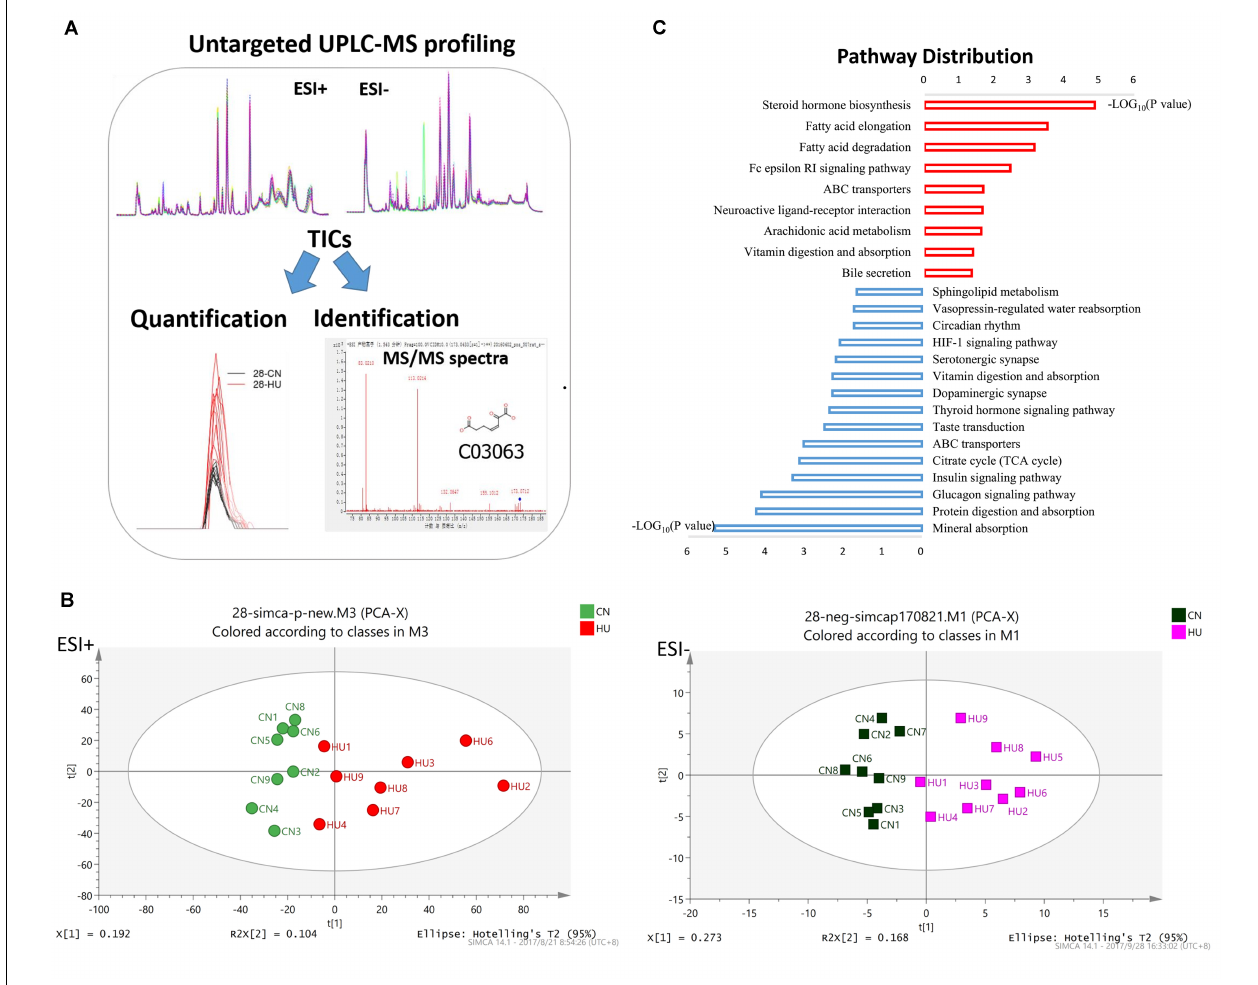
FIGURE 1 | Serum metabolomics reveals different metabolic profiles between control and HU rats. (A) Metabolomic workflow. (B) PCA plot of scores separating HU-28 (red in ESI+ and pink in ESI–) and control (green in ESI+ and black in ESI–) serum samples. (C) Abundance of discriminating metabolites in pathways according to KEGG analysis. The red column or blue column represents an increase or decrease pathway, respectively.